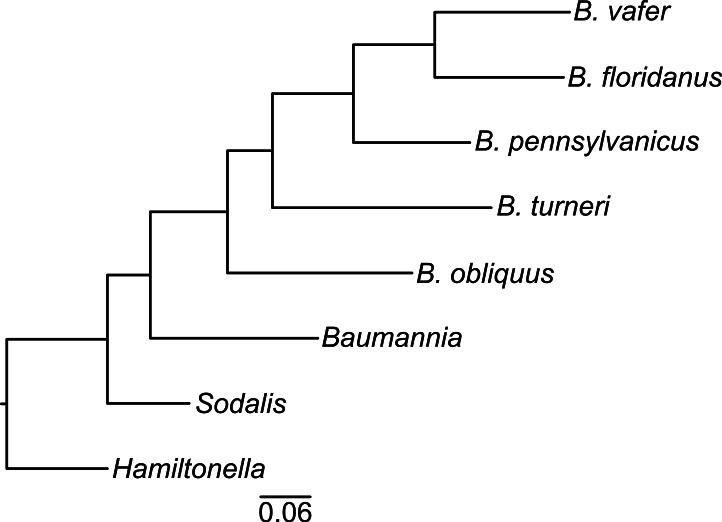
Blochmannia phylogeny.The phylogeny was constructed by Bayesian analysis of concatenated amino acid sequence alignments for 30 genes. The phylogeny is artificially rooted on the branch leading to Hamiltonella. All nodes have 100% posterior probability. The scale bar shows amino acid substitutions.